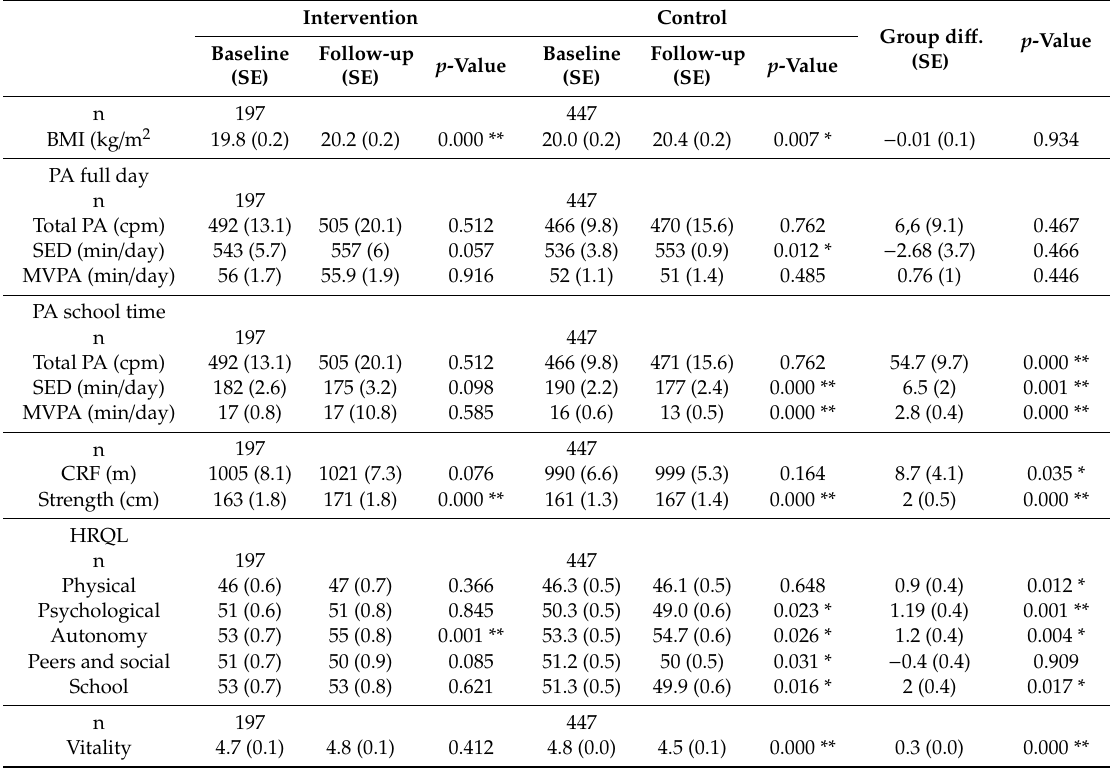
Table 3. Mean (SE) baseline, follow-up and group (intervention–control) di ff erences (SE) with p -values indicating significant changes. Intervention Control Baseline